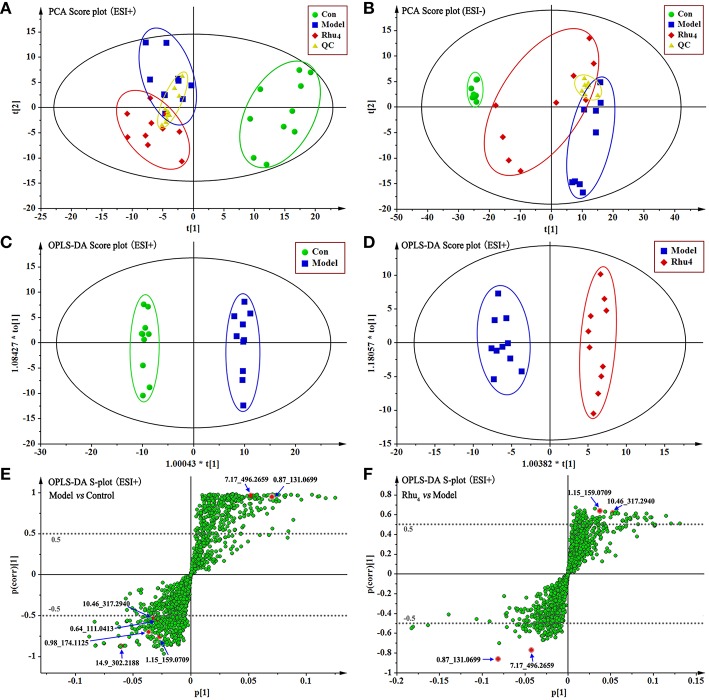
The score plots of Con, Model, Rhu4, and QC from PCA in the ESI+ mode (A) and ESI− mode (B) for PC1 vs. PC2. QC indicates the quality control group. OPLS-DA analysis of the data derived from the ESI+ mode. OPLS-DA score plots for the pair-wise comparisons between the Con and Model (C) and the Model and Rhu4
(D). S-plot of the OPLS-DA model for the Con and Model (E) and the Model and Rhu4
(F), the axes that are plotted in the S-plot from the predictive component are p1 vs. p(corr)1, representing the magnitude (modeled covariation) and reliability (modeled correlation) respectively. The points in red indicate the identified biomarkers.